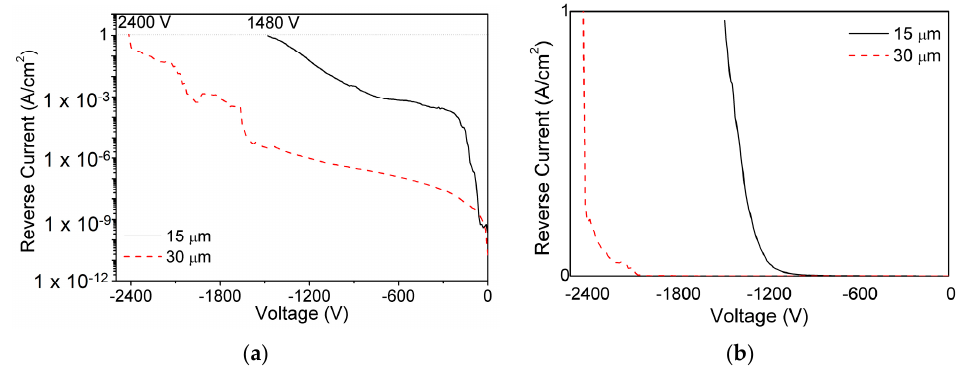
Figure 14. Reverse breakdown voltage characteristics of SBDs with 15 μ m and 30 μ m in ( a ) log and ( b ) linear scale.